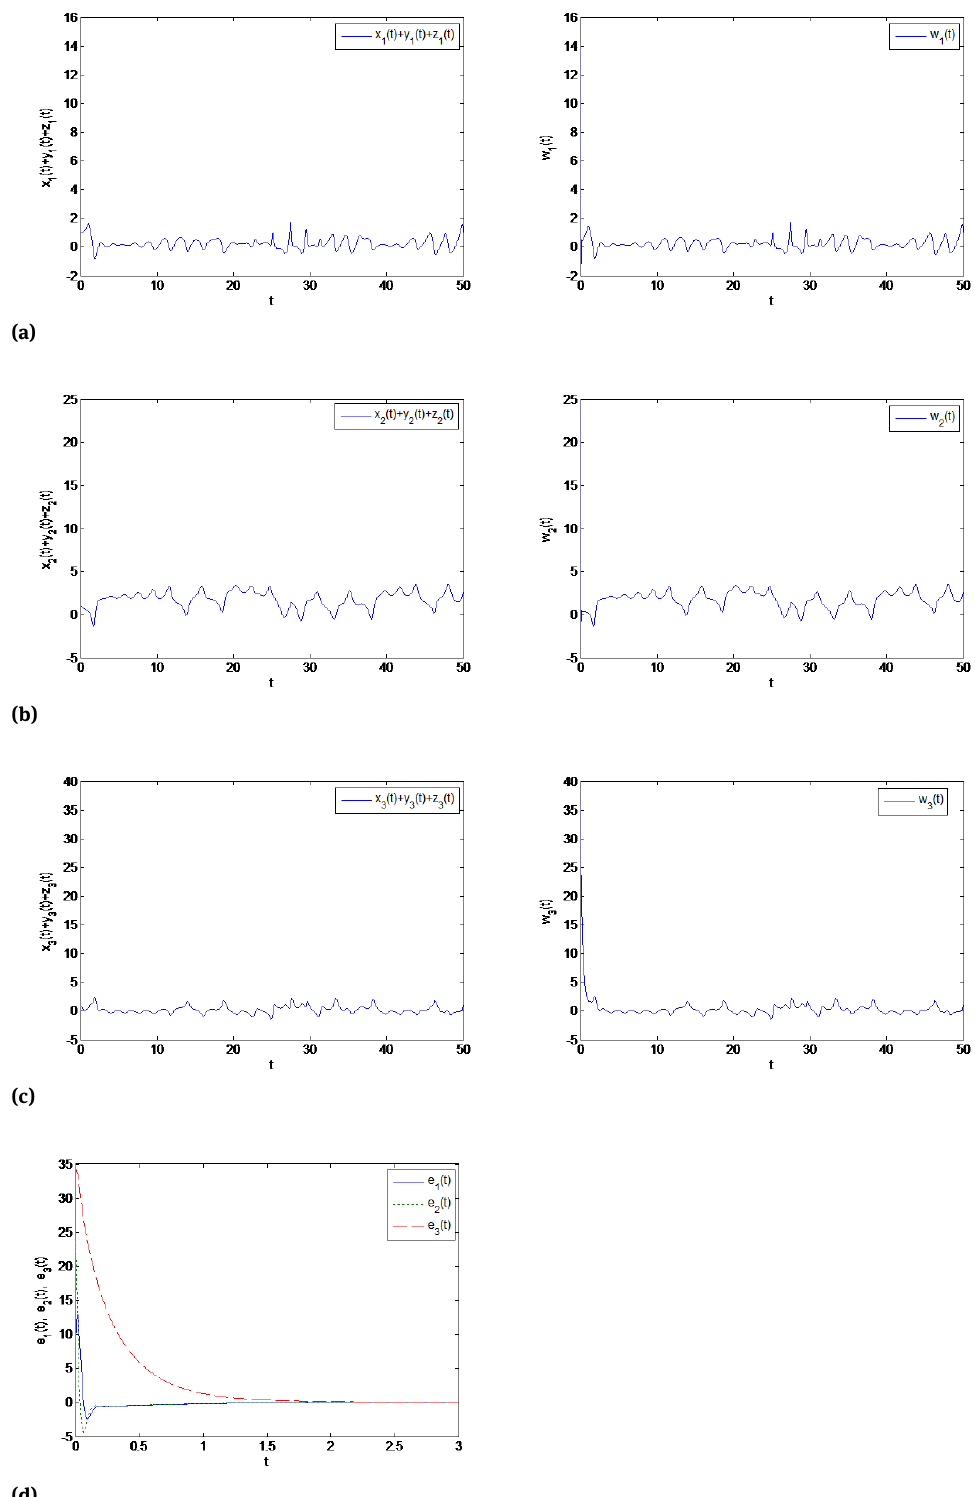
Fig. 3: Combination synchronization among four fractional order chaotic systems (5), (6), (7) and (8) for fractional order q = 0.95 : (a) be- tween x 1 ( t ) + y 1 ( t ) + z 1 ( t ) and w 1 ( t ) , (b) between x 2 ( t ) + y 2 ( t ) + z 2 ( t ) and w 2 ( t ) , (c) between x 3 ( t ) + y 3 ( t ) + z 3 ( t ) and w 3 ( t ) , (d) the evaluation of error functions e 1 ( t ), e 2 ( t ) and e 3 ( t )